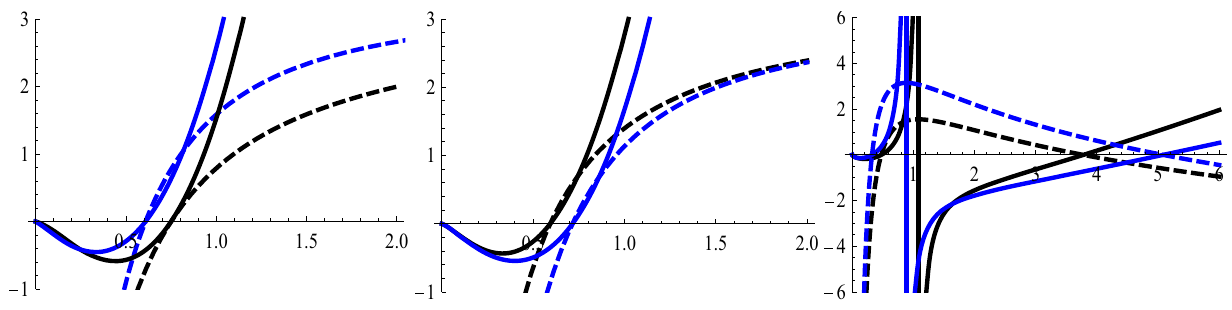
Fig. 4 T ( dashed ) and C Q ( continues ) versus r + for (cid:11) = − 3 , b = 1, Eqs. (3.1) and (4.1). Left: α < 1, 4 T and C Q : Q = 2 , a = 1 . 22 and α = 0 . 6 ( black ), 0 . 7 ( blue ) . Middle: α < 1, 4 T and C = 2 , α = 0 . 75 and a = 1 ( black ), 1 . 5 ( blue ) . Right: α > 1, 10 T and 0 . 5 C Q : Q Q = 1 , b = 1 , a = 1 and α = 1 . 3 ( black ), 1 . 45 ( blue